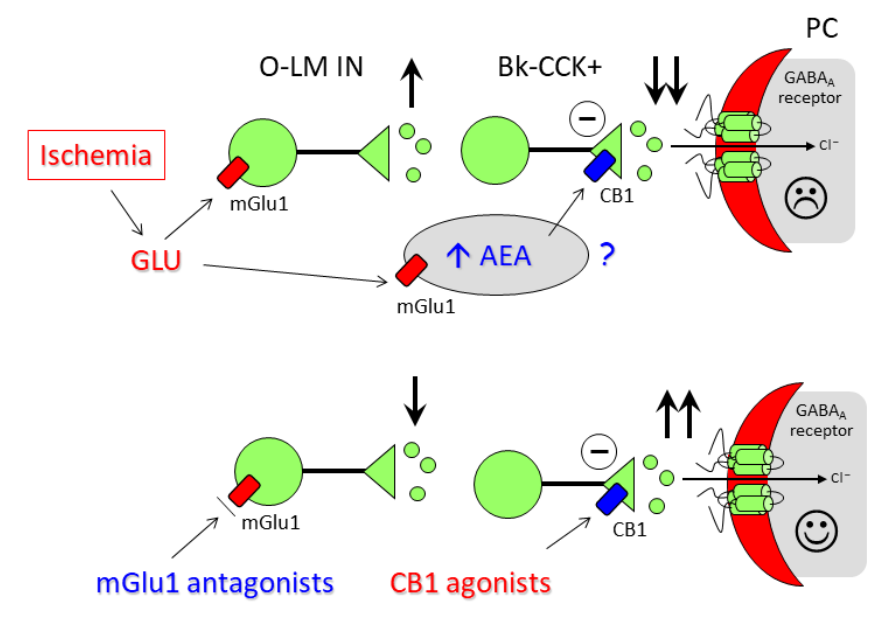
Figure 7. Polysynaptic GABAergic disinhibition model. mGlu1 are postsynaptic and CB1 receptors presynaptic in different interneuron populations connected in series. During ischemia, glutamate activates mGlu1 receptors in stratum oriens-stratum lacunosum moleculare GABAergic interneurons (O-LM IN) increasing their firing and leading to inhibition of CCK-positive basket cell (Bk-CCK+) that innervate the dendrites or the perisomatic region of CA1 pyramidal cells (PC), which results in a reduction in the release of GABA, disinhibition of excitatory inputs from the Schaffer collateral pathways and degeneration of CA1 pyramidal cells. mGlu1 antagonists will counteract this mechanism and, therefore, increase the net output of GABA upon pyramidal cells and provide neuroprotection, CB1 receptor agonists will reduce the output from basket cell terminals and prevent this effect.